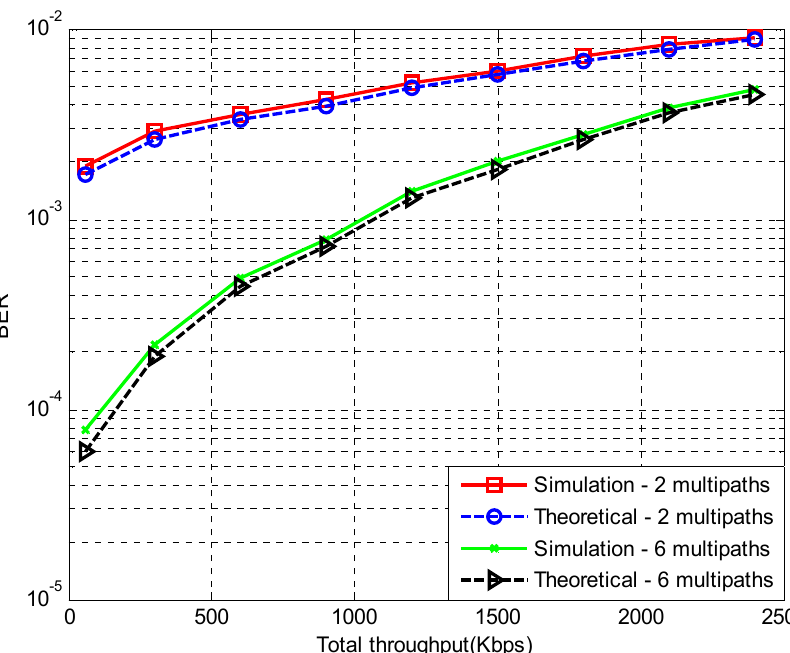
Figure A2. Simulation and theoretical BER for a 4 × 2 MIMO—WCDMA network.